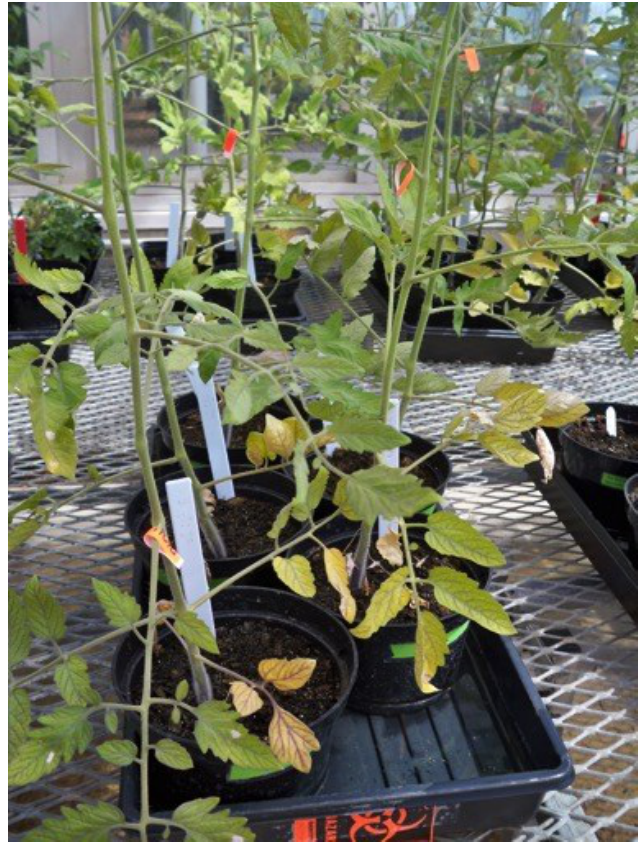
Figure 2. Red Currant tomato plants that had been leaf inoculated with E. coli O157:H7-GFP.